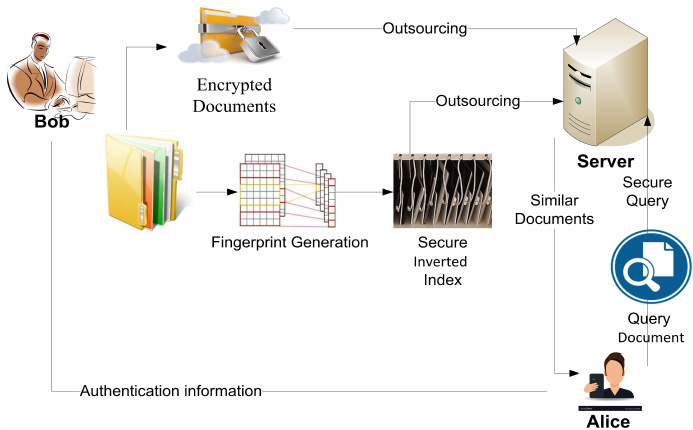
Figure 1. The proposed privacy-preserving